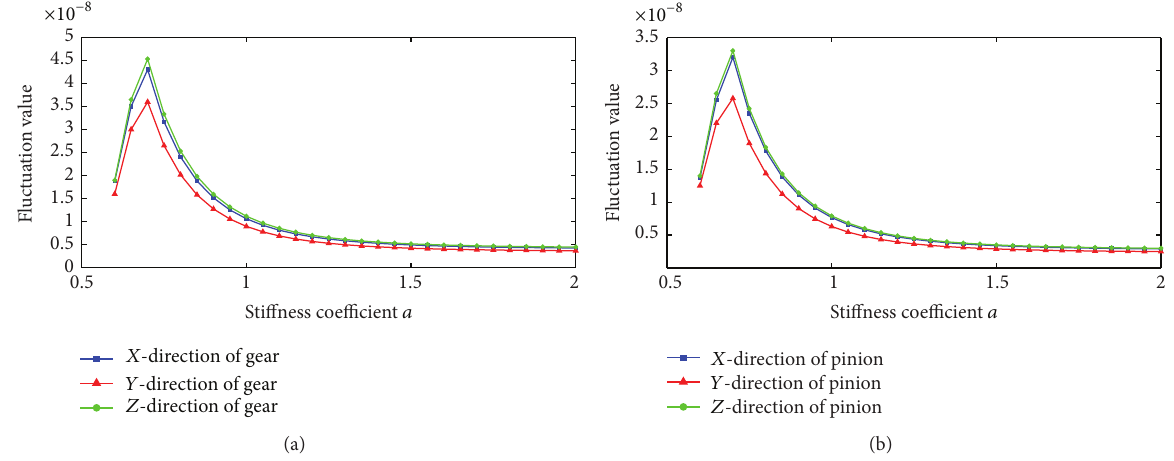
Figure 4: Influence of bearing stiffness on bending vibration of the hypoid gear.